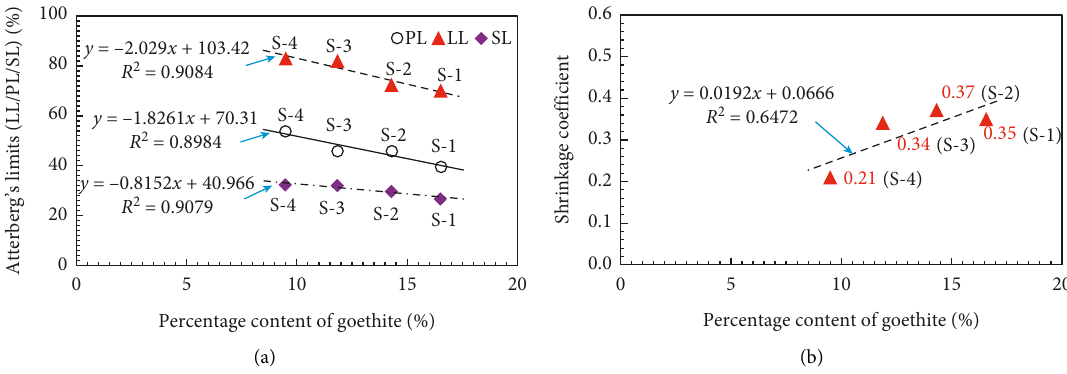
Figure 7: Relationships between goethite and physical properties of lateritic clay. (a) Relationship between goethite content and Atterberg’s limits. (b) Relationship between goethite content and shrinkage